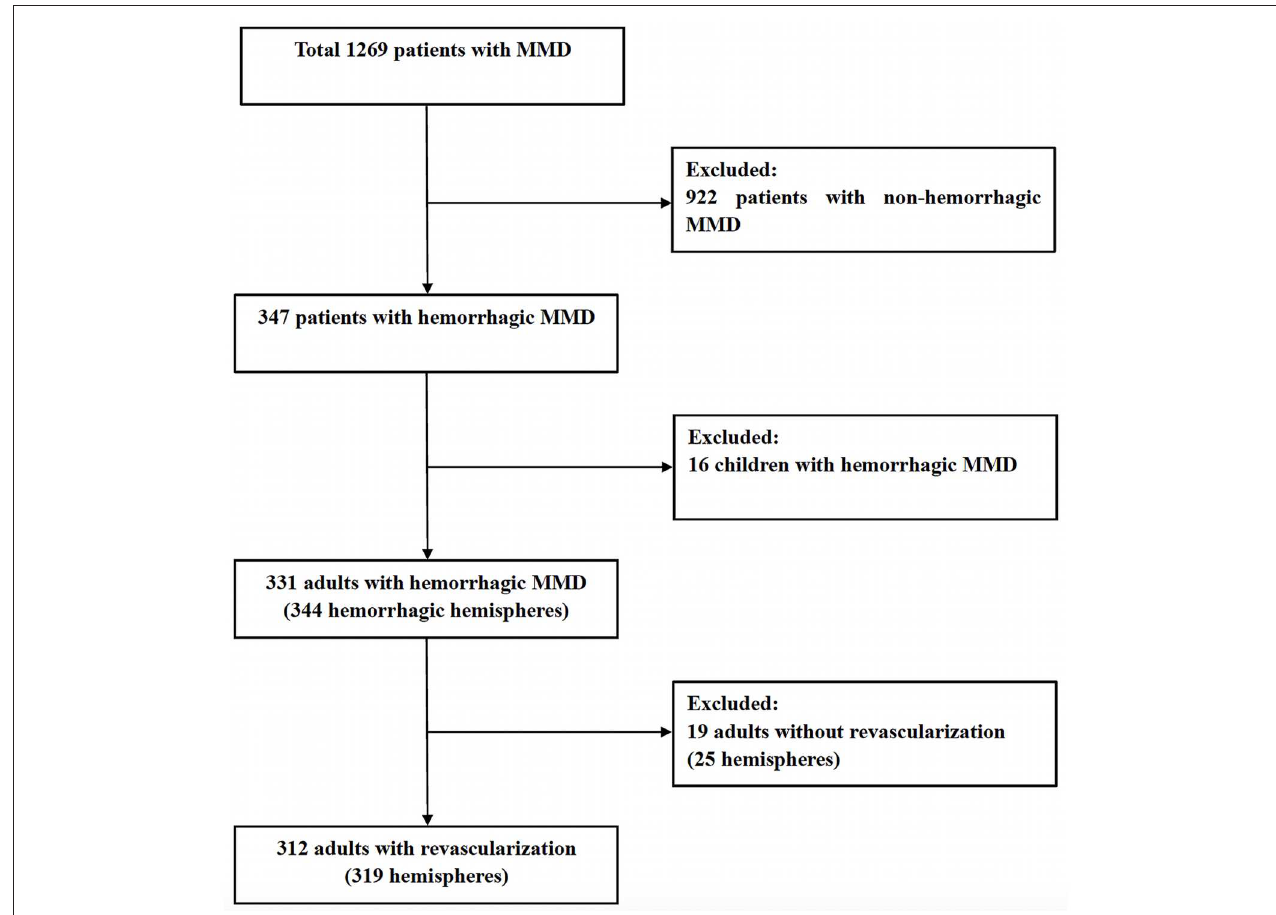
FIGURE 1 | Study flow chart of patient